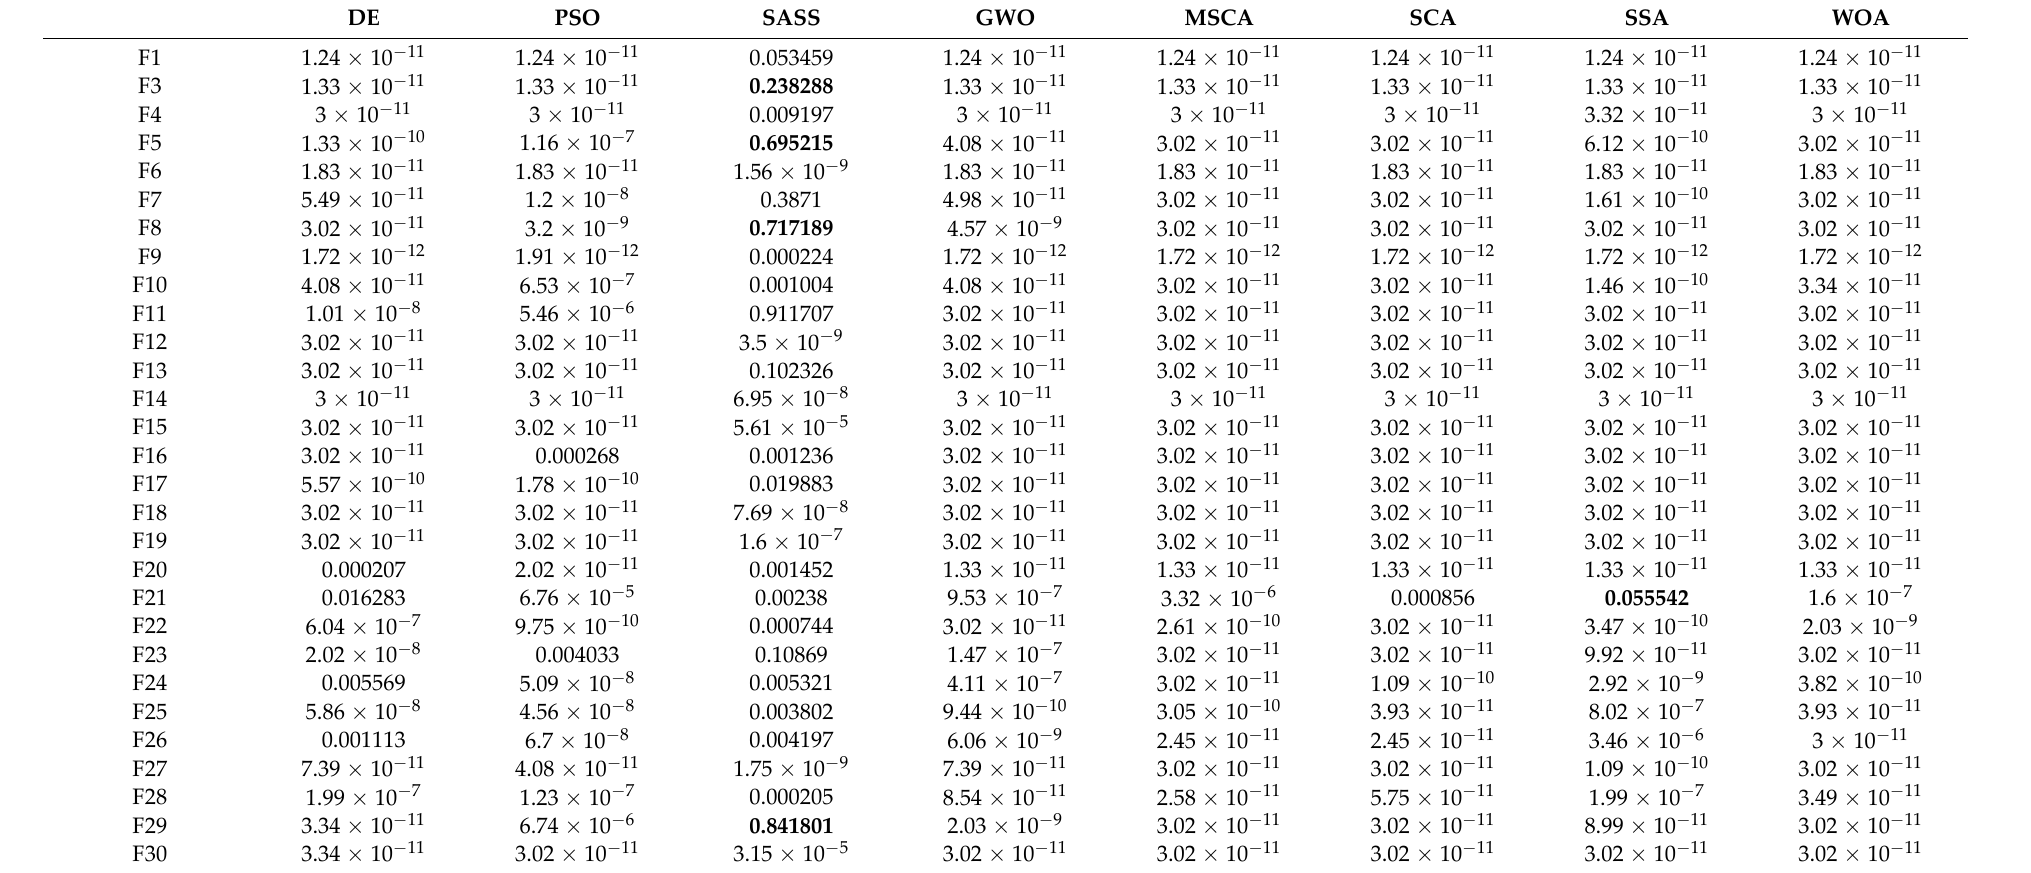
Table 3. The calculated p ‑values for the SSDE algorithm versus other competitors on